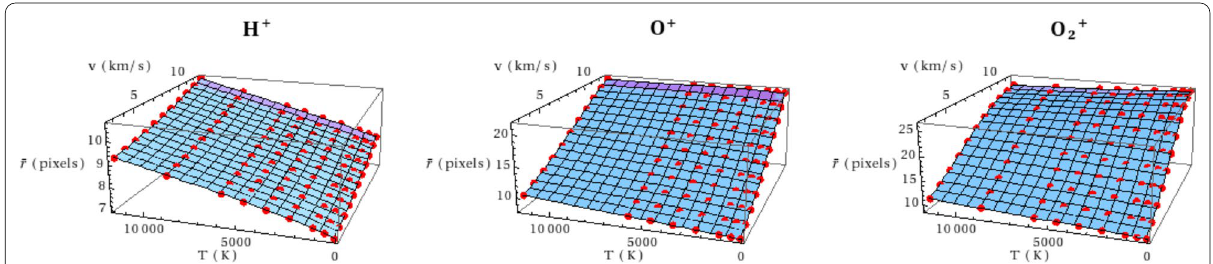
Fig. 19 Least-squares fits (blue surfaces) of EES Gaussian image model parameter r (Equation C.10) to the values determined from TII MCS (red points) as a function of ion ram speed and ion temperature for the three ion species simulated